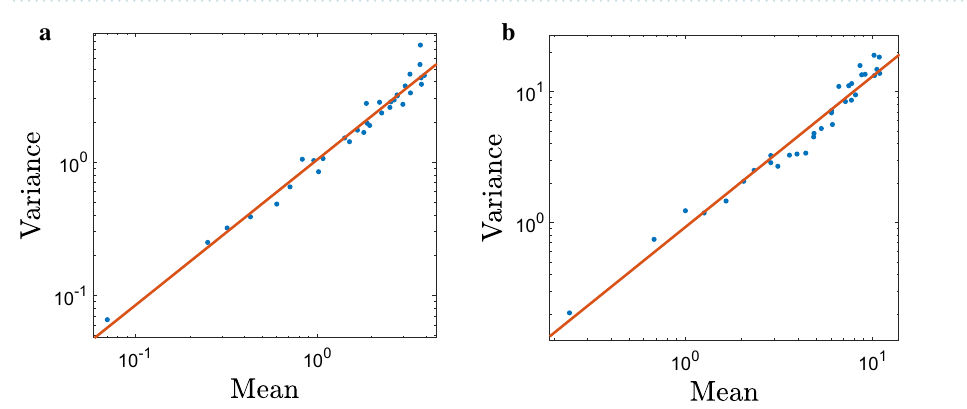
Figure 9. The spatial distribution of simulated trap counts (the population size in the central cell, see details 10 4 slugs for different parameters of density dependence: ( a ) d in the text) obtained for N = d 1 , R 10 , R 1 and ( c ) d 2 . Other parameters are as in Fig. 2. = = = =